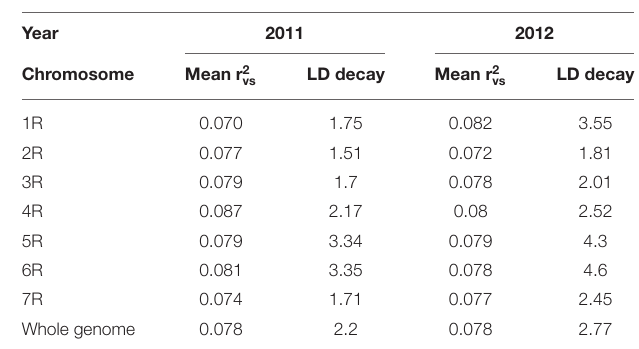
TABLE 4 | Estimates of LD as well as distances at which LD decays below background LD for single cross hybrids in 2011 and